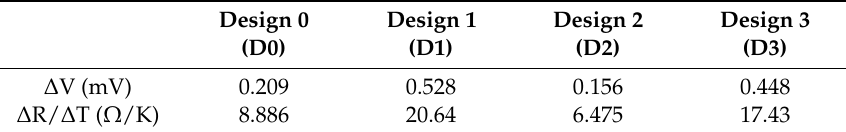
Table 5. ∆ V and ∆ R/ ∆ T of 4 proposed microbolometer structures are measured. Table 5. Δ V and Δ R/ Δ T of 4 proposed microbolometer structures are measured.